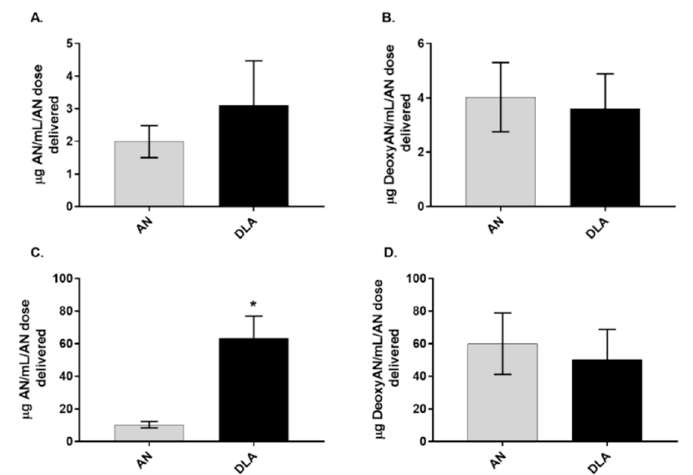
Figure 4. Artemisinin (AN) and deoxyartemisinin (DeoxyAN) accumulation in urine of male ( A , B ) and female ( C , D ) rats after oral delivery of artemisinin as dried leaf A. annua (DLA) or pure artemisinin. n = 8, *; p ≤ 0.05; error bars = SEM.